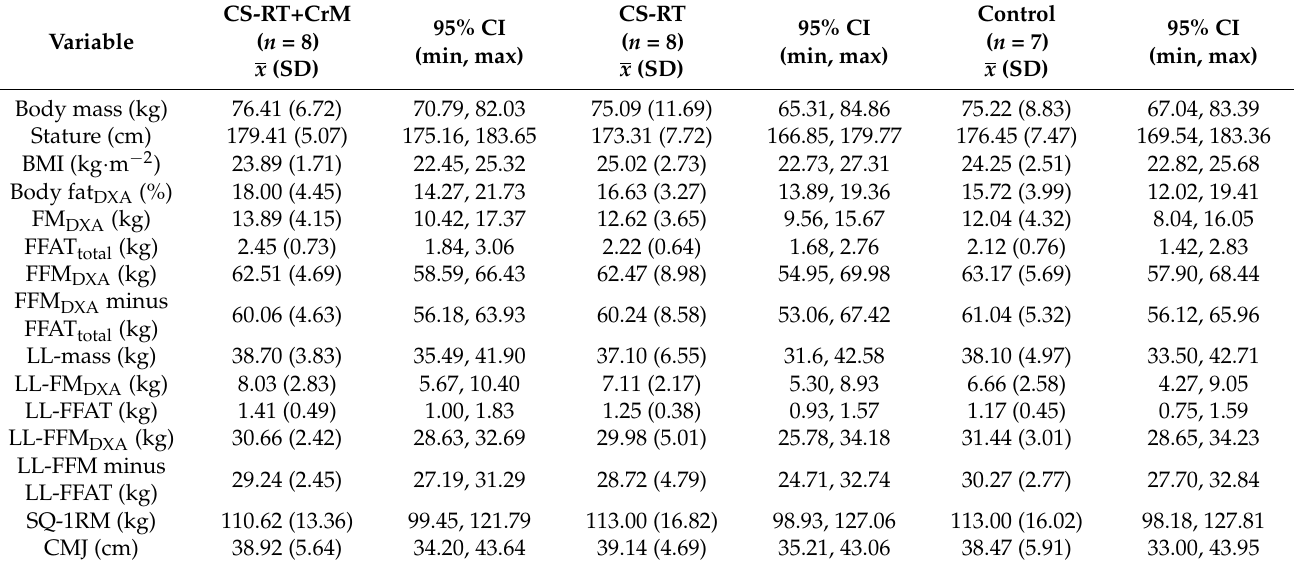
Table 2. Descriptive information of participants at